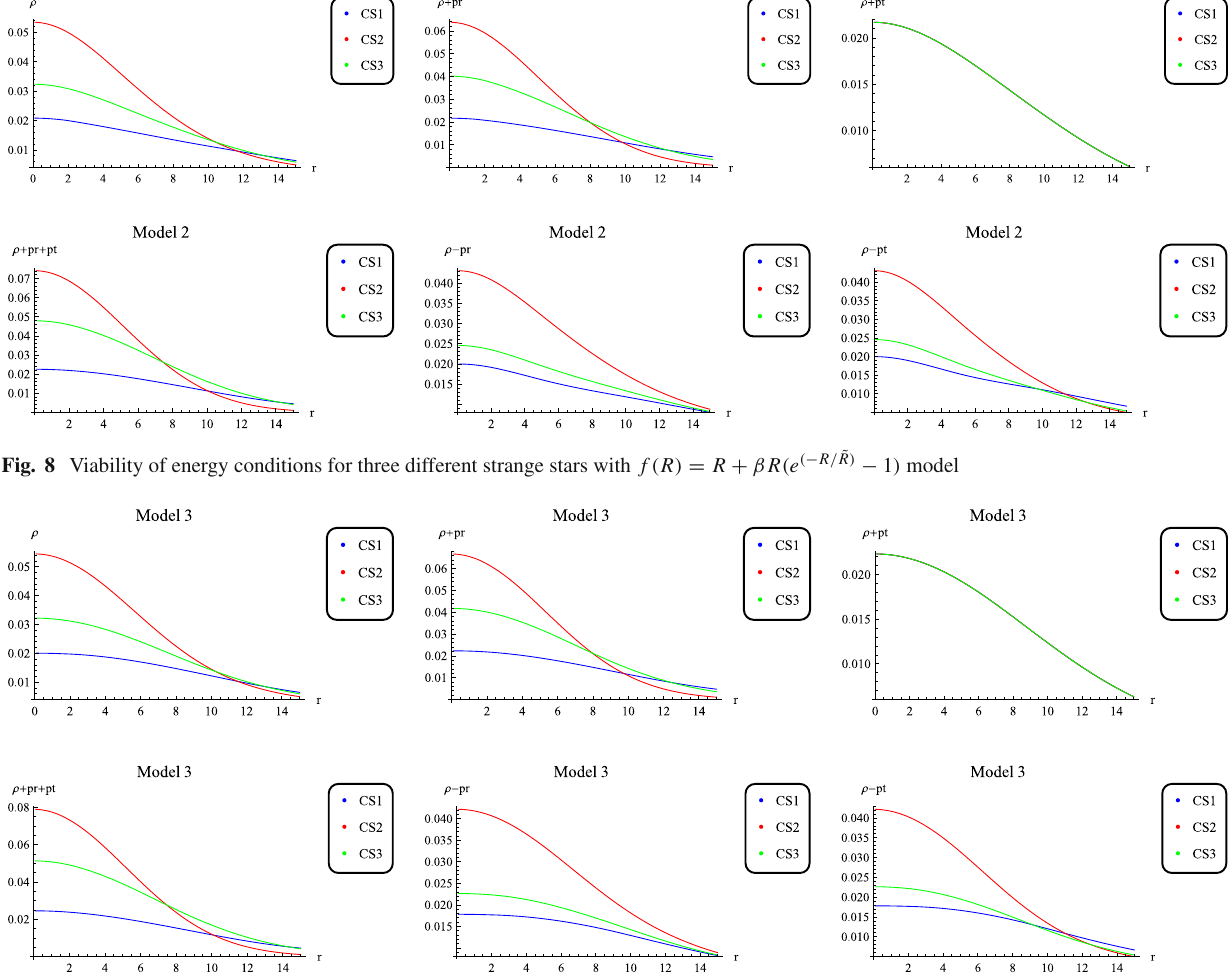
Fig. 9 Viability of energy conditions for three different strange stars in the presence of f ( R ) = R + α R 2 ( 1 + γ R ) corrections Equation (22) can be relabeled in terms of gravitational ( F g ) ,